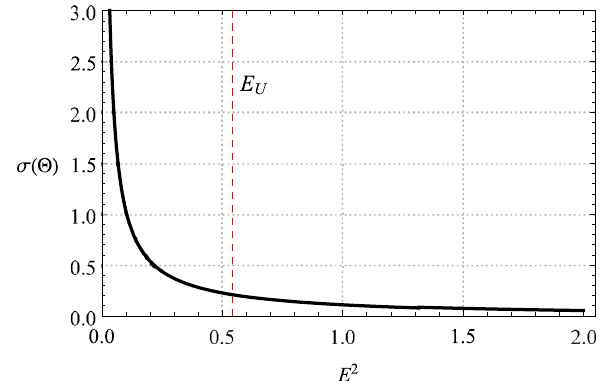
Fig. 6 The evolution of σ(Θ) in terms of E 2 , plotted for L = 0 . 8, Q = 0 . 5 and λ = 0 . 6. For these values, E 2